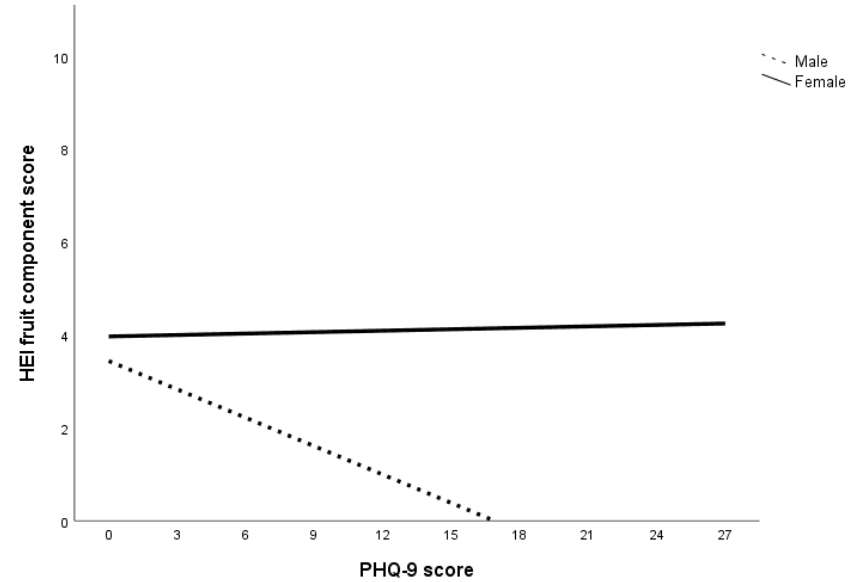
Figure 2. The relationship between depression and fruits consumption across sex. Note. Lower HEI fruits component score indicates lower consumption of fruits.